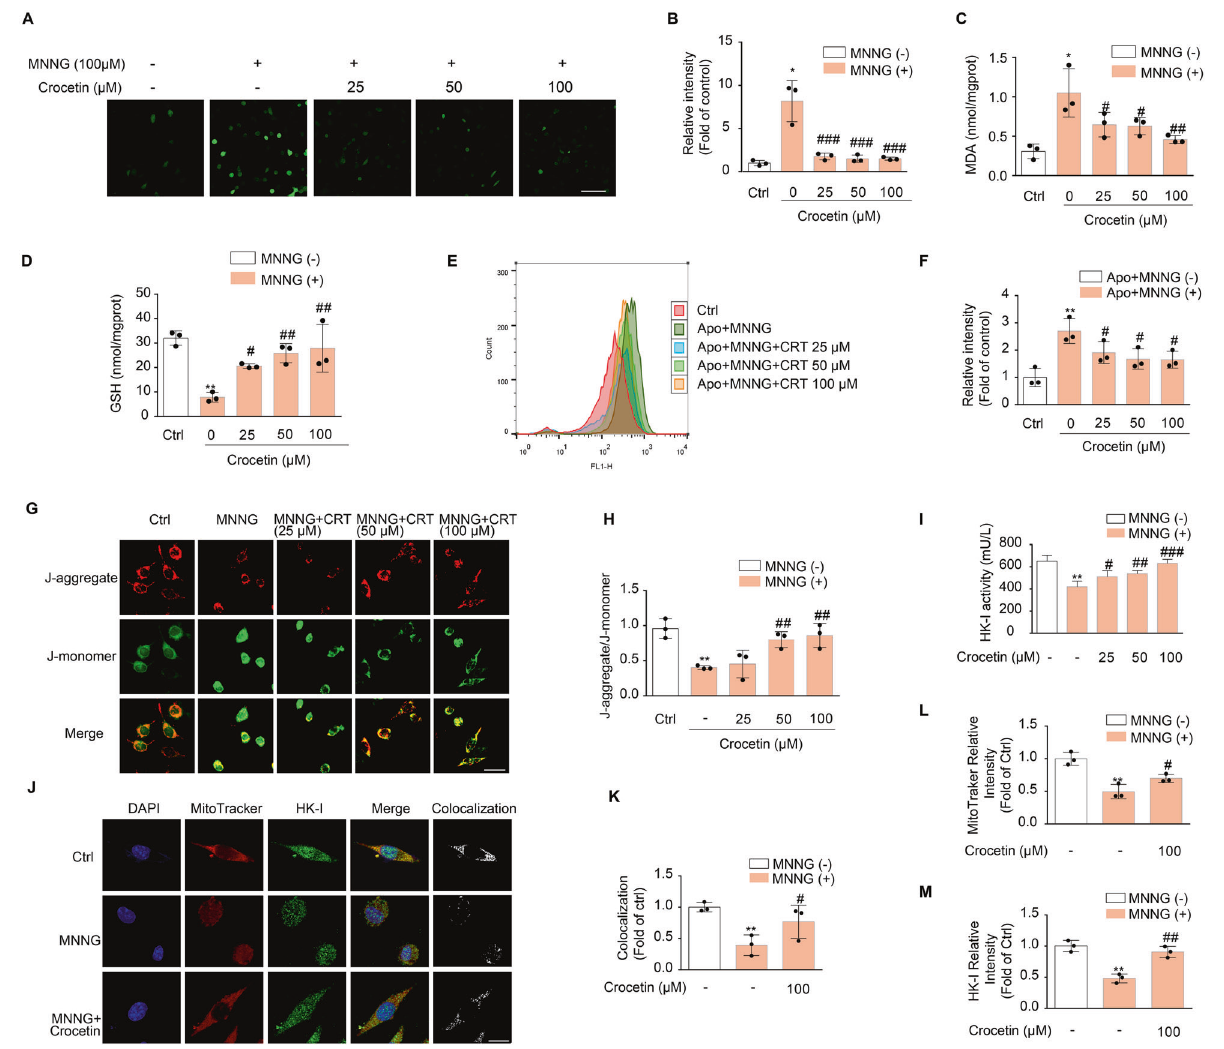
microscopy (Scale bar is 40 μ m). B Group quanti fi cation of the green fl uorescent intensity in ( A ) from three independent experiments. C , D Effect of crocetin on MDA level ( C ) and GSH level ( D ) in MNNG-induced late stage of parthanatos. E , F Effect of crocetin on MNNG-induced the late stage of ROS generation. Cells were co-pretreated with indicated concentrations of crocetin and/or apocynin (100 μ M) for 1 h, then exposed to MNNG (100 μ M) for 4 h. Intracellular ROS was expressed as mean fl uorescence intensity which was quanti fi ed by fl ow cytometry. (G) Effect of crocetin on MNNG-induced mitochondria membrane potential in SH-SY5Y cells. Cells were pretreated with indicated concentrations of crocetin for 1 h, then exposed to MNNG (100 μ M) for 4 h. JC-1 staining pattern includes J-aggregate(red) at high MMPs and J-monomer(green) at low MMPs. Fluorescence change from red to green indicated a decrease of MMPs. Scale bars: 10 μ m. H Group quanti fi cation of the red and green fl uorescent intensity in ( G ) from three independent experiments. I Effect of crocetin on MNNG-induced HK-I activity decrease in SH-SY5Y cells. J Effect of crocetin on MNNG-induced HK-I release from mitochondria assessed by immunostainings with anti-HK-I (in green) and Mito Tracker Red (in red); nuclei were stained with DAPI (blue). K Colocalization between HK-I and mitochondria measured by Image J. L Group quanti fi cation of the red fl uorescent intensity in ( K ) from three independent experiments. M Group quanti fi cation of the green fl uorescent intensity in ( K ) from three independent experiments. Signi fi cance was determined by one-way ANOVA. * p < 0.05, ** p < 0.01 vs control group; # p < 0.05, ## p < 0.01, ### p < 0.001, vs MNNG